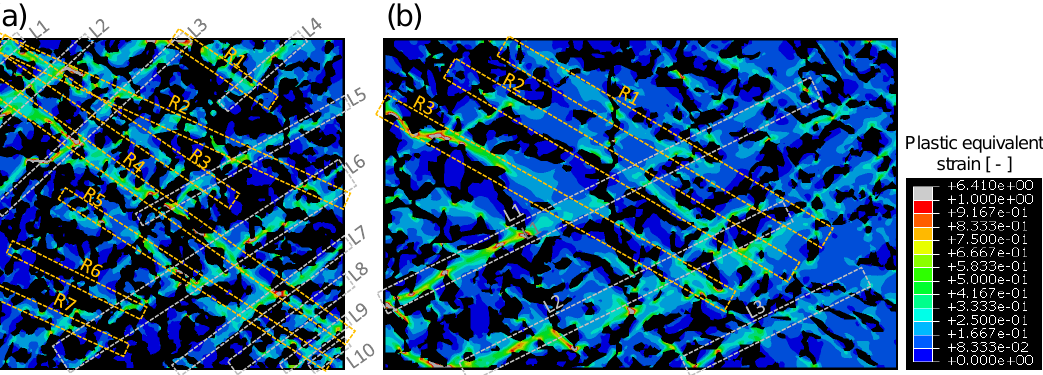
Figure 18. Distributions of plastic equivalent strain of ferrite at the start of necking in: ( a ) DP5; and ( b ) DP2.